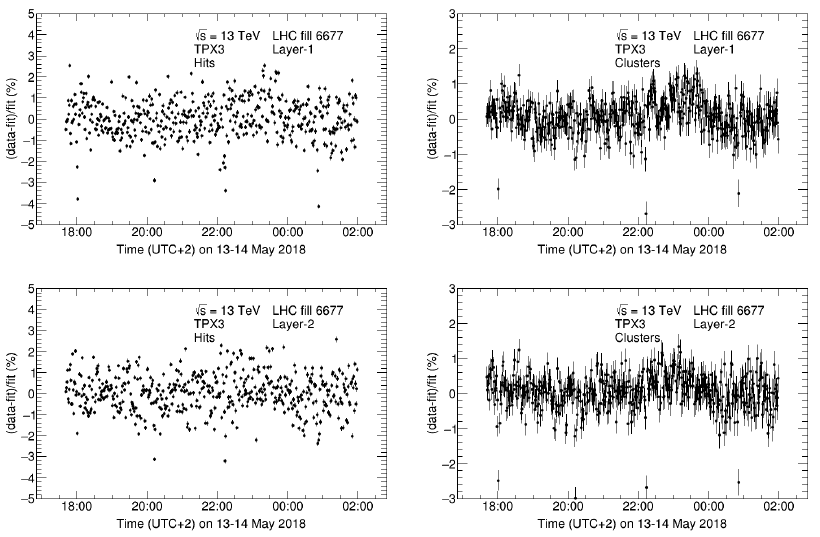
Figure 62. Relative difference between data and fitted luminosity curve as a function of time, seen by TPX3 for layers 1 and 2, in hit- and cluster-counting analyses in LHC fill 6677. The statistical uncertainties are given, which in the hit-counting analysis are much smaller than in the cluster analysis. The cluster analysis takes the correlations into account, resulting from the fact that one particle typically creates many hits. The TPX3 data are grouped into LB time periods of typically 60s. Taken from Ref.